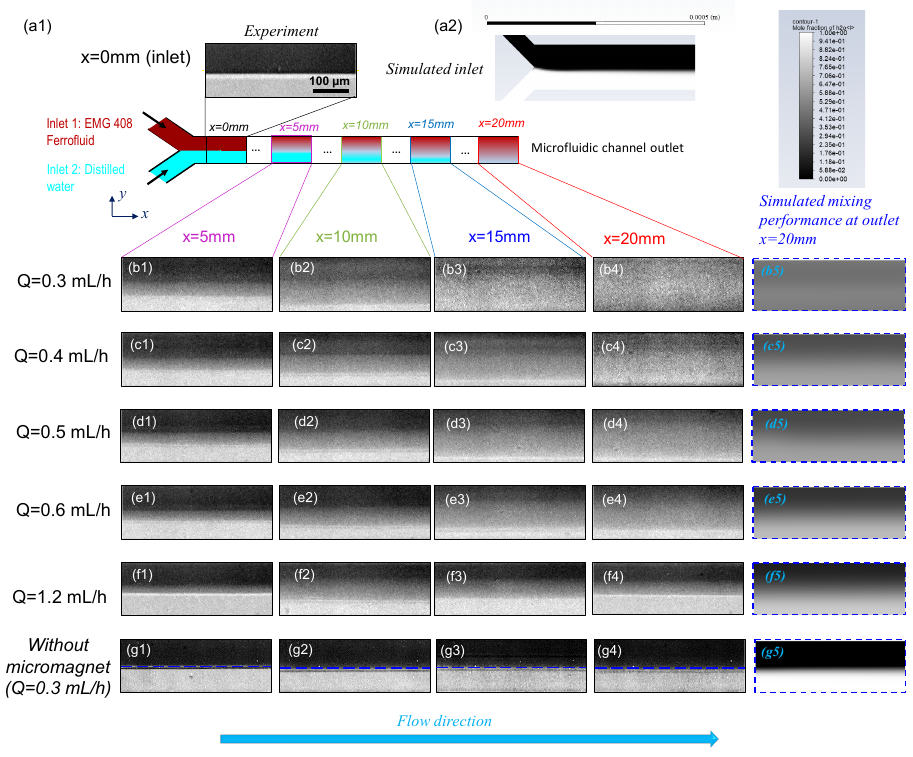
Figure 5. E ff ect of total flow rate Q on mixing performance. ( a1 ) is the experimental distribution of ferrofluid and distilled water. ( a2 ) is the corresponding simulation results for mole faction of nano Fe 3 O 4 particles in ferrofluid at inlet of microfluidic channel. ( b1 – b4 ) are a group of images at di ff erent downstream positions x = 5 mm, x = 10 mm, x = 15 mm, and x = 20 mm ( outlet ) of microfluidic channel when the total flow rate Q = 0.3 mL/h. ( b5 ) is the simulated mixing performance at outlet. The color represents the mole faction of nano Fe 3 O 4 particles in ferrofluid and its legend is the same with that in ( a2 ). Groups ( b )–( f ) are the corresponding experimental and simulated results for various total flow rate of Q = 0.4 mL/h, Q = 0.5 mL/h, Q = 0.6 mL/h, and Q = 1.2 mL/h, respectively. Group ( g ) is the experimental and simulated distribution of ferrofluid and distilled water without the e ff ect of magnetic fields when Q = 0.3 mL/h. The flow rate ratio between ferrofluid to distilled water is 1:1, and the ferrofluid magnetic nanoparticle concentration is 1.2% (v / v) for all the groups from ( a – g